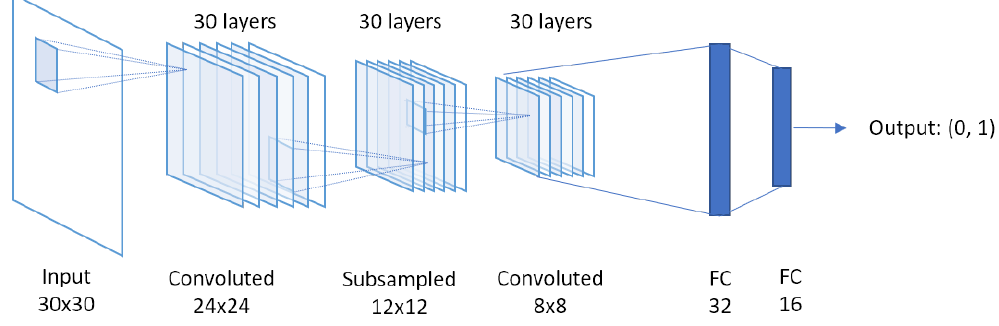
Figure 2 . Convolutional Neural Network (CNN) architecture used for boosted top-jet